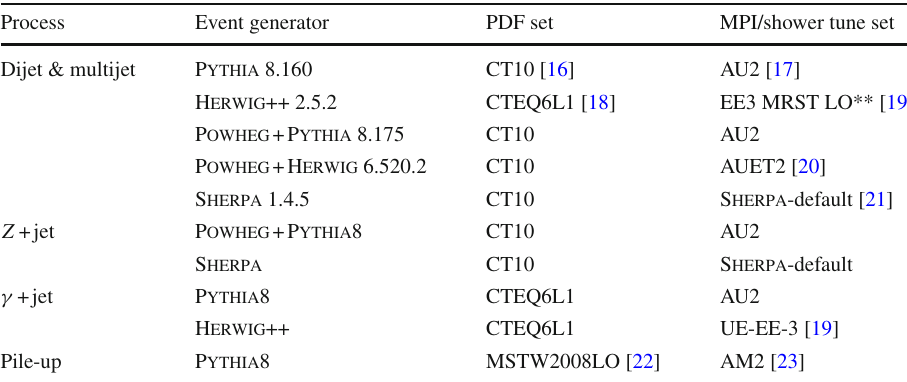
Table 1 Summary of the simulated samples used to derive the jet calibration and to assess systematic